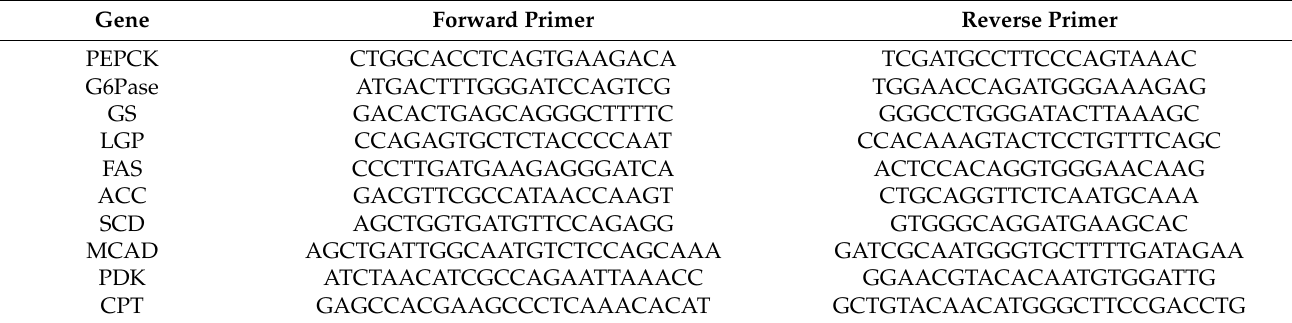
Table 4. List of primers used in this study for gene expression